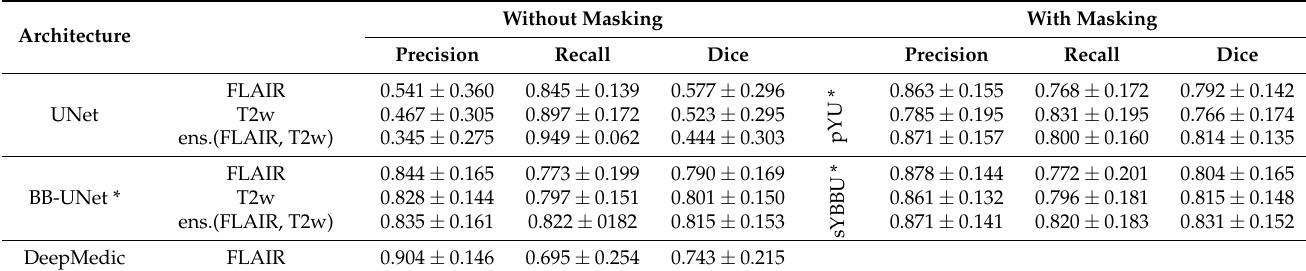
Table 6. Segmentation results on LGG test with 76 test patients. Results present the mean ± standard deviation.